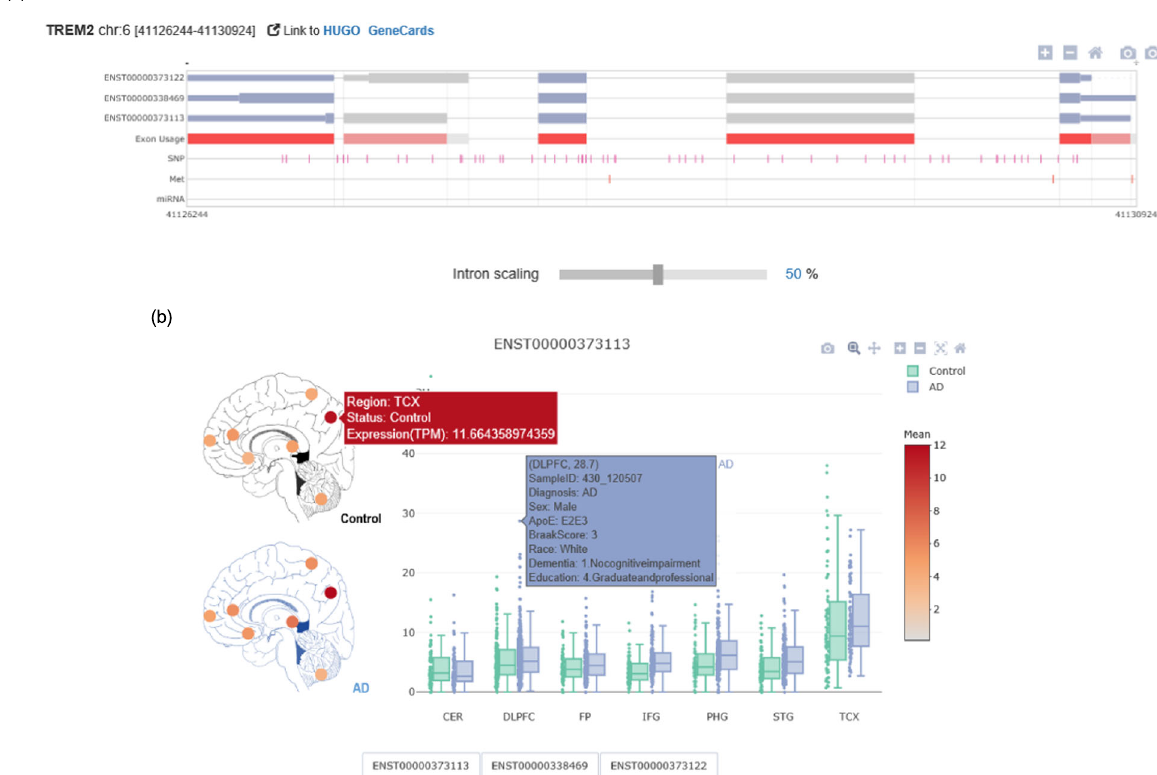
Fig. 1 AS transcript navigator and visualizing transcript expression distribution across the seven brain regions. a The AS transcript navigator visualizes splicing of the transcripts of a given gene and the positions of SNPs, methylation, and miRNAs. Intron scaling allows adjusting relative intron and exon lengths. b Region-speci fi c expression levels of a given transcript in normal and AD groups are visualized through a brain image heatmap (left) and a boxplot (right). In the heatmap, color is based on the average TPM value of the brain region, and hovering over each point shows detailed information. In the boxplot, each point indicates an individual, which can be hovered over to display corresponding clinical